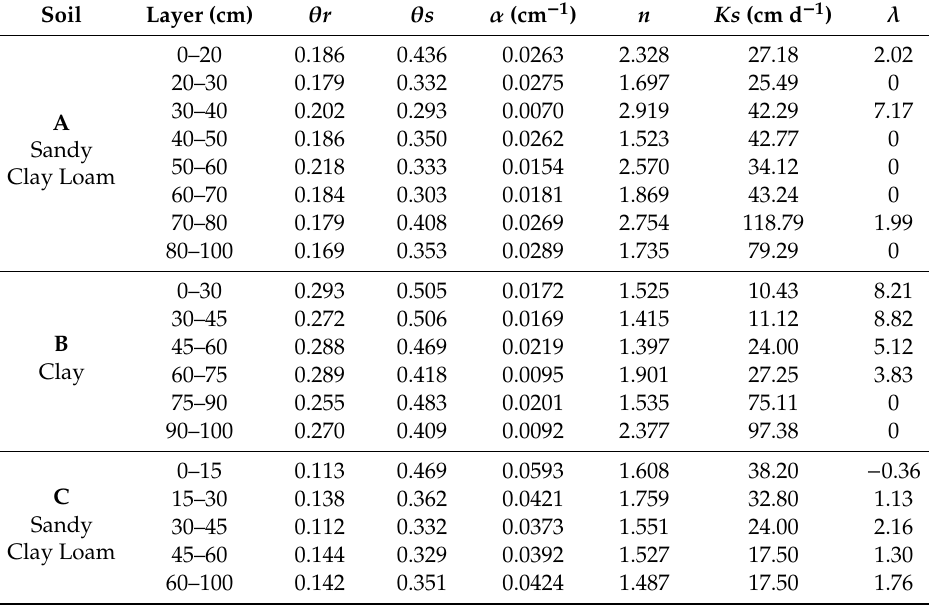
Figure 1. Geographical position of sampled soils (A to H) and the University of São Paulo weather station (MS) in Piracicaba (SP), Brazil. Table 1. Hydraulic parameters of the soils according to the Van Genuchten equation.